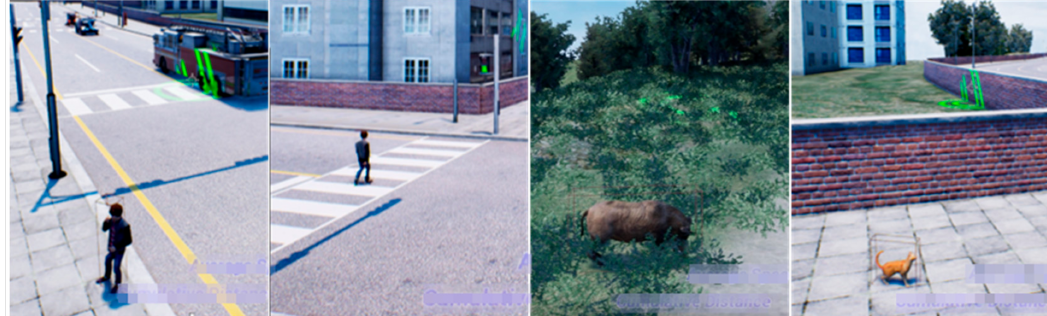
Figure 9. Simulated agents in normal mode. From left to right: boy speaking on phone, boy crossing the road at pedestrian crossing, boar eating, and cat sitting on the